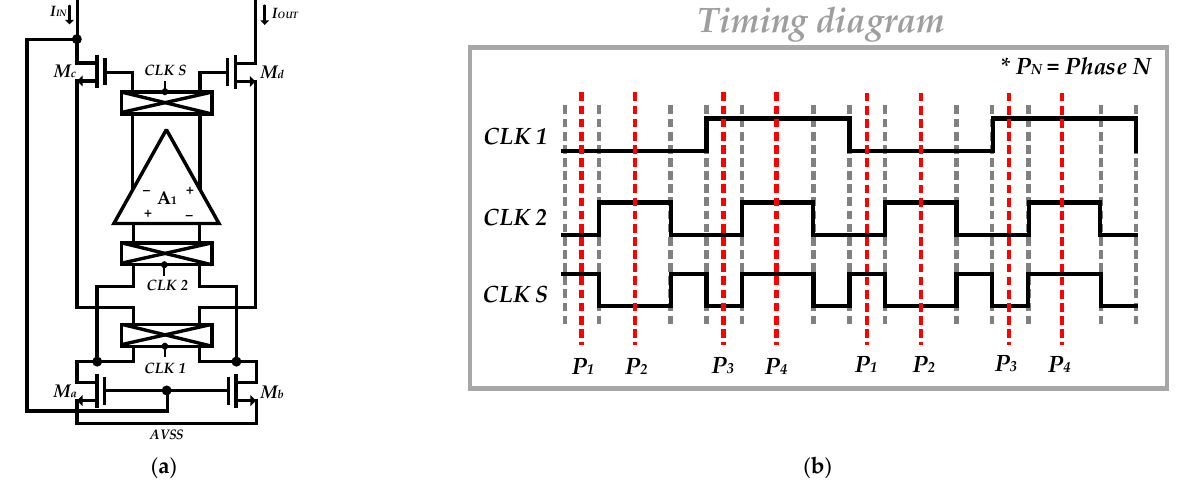
Figure 4. ( a ) Architecture of the proposed current mirror; ( b ) timing diagram of the chopper with current mirror using the DEM technique.